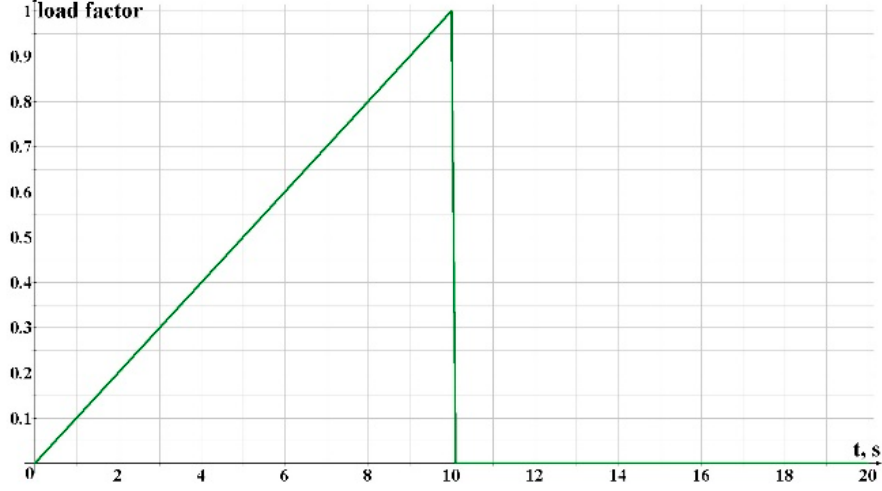
Figure 8. The graph of the change in the forces in the damaged element with the exclusion time Δ t = 0.01 s.